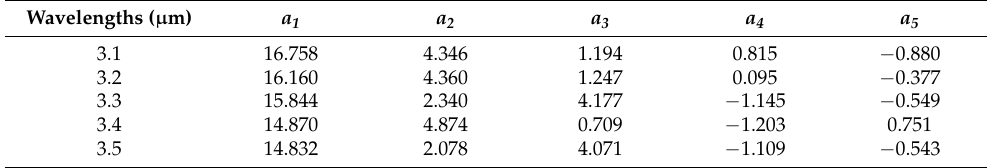
Figure 2. Flowchart of optimization procedures, including ray-tracing optimization and particle- swarm optimization. Table 1. Phase-profile coefficients a i of the aperture metalens at wavelengths from 3.1 to 3.5 µ m.